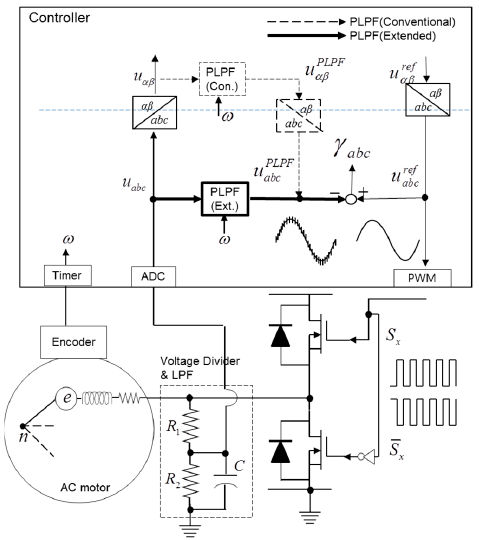
Figure 14. Comparison of signal flows between conventional PLPF and extended PLPF for the